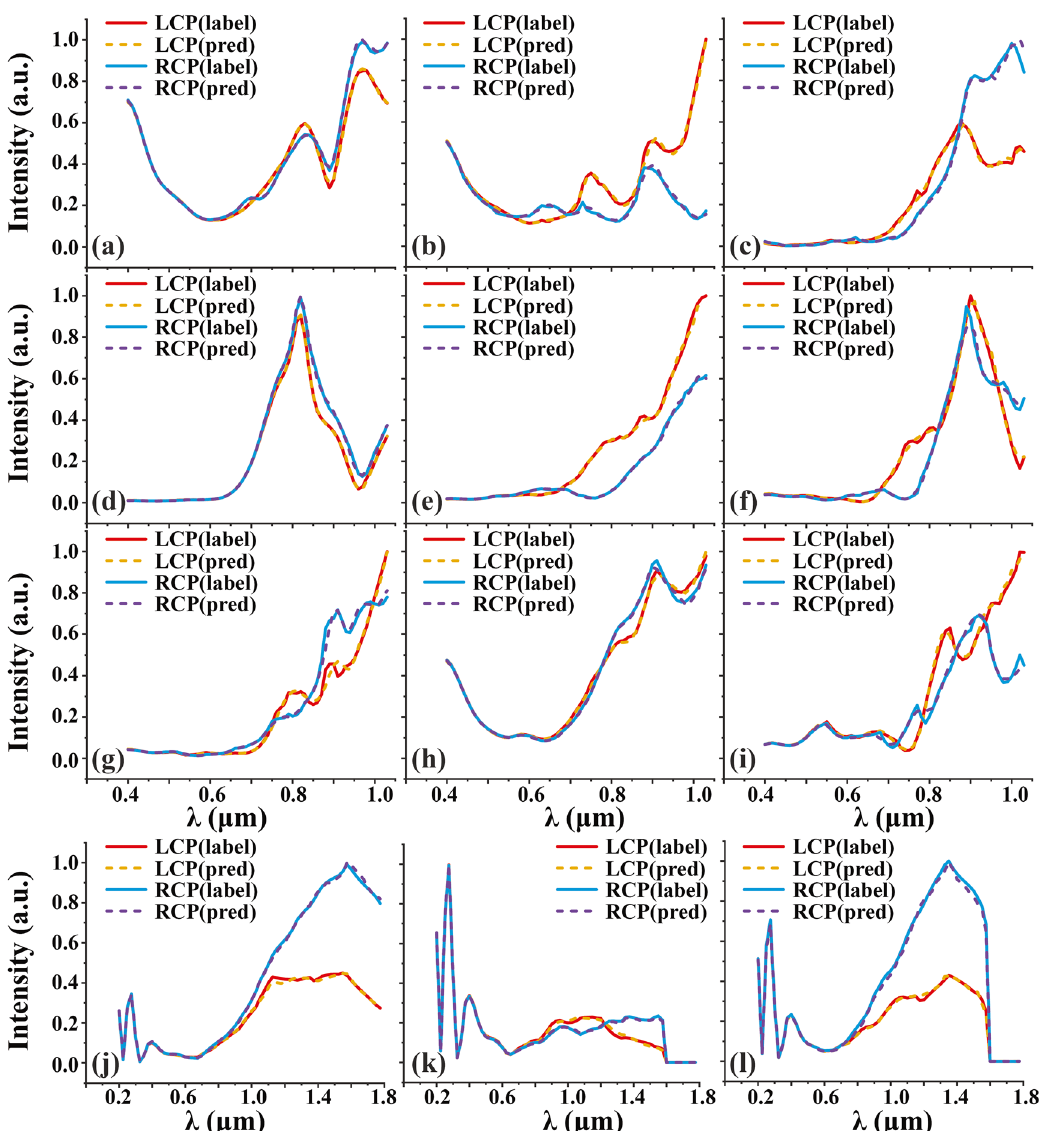
Figure 5: Comparison of the third-order diffracted chiroptical response calculated by rigorous coupled wave analysis (RCWA) (label) and a model-agnostic data enhancement (MADE) plus artificial neural network (ANN) model